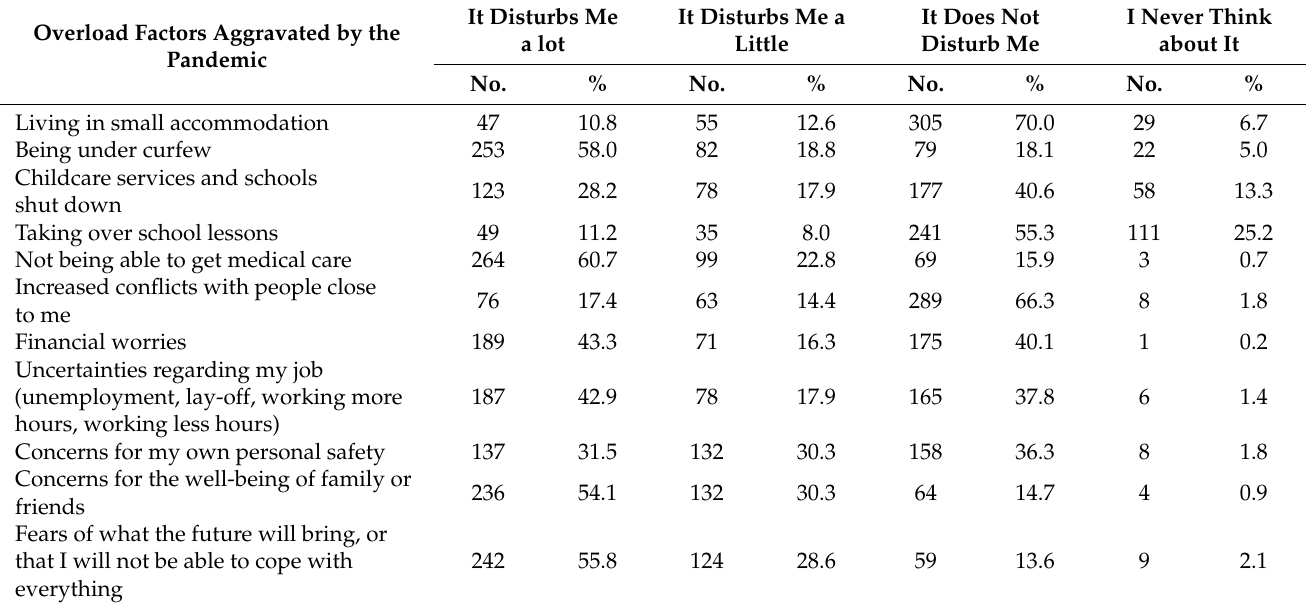
Table 5. Overload factors aggravated by the pandemic.